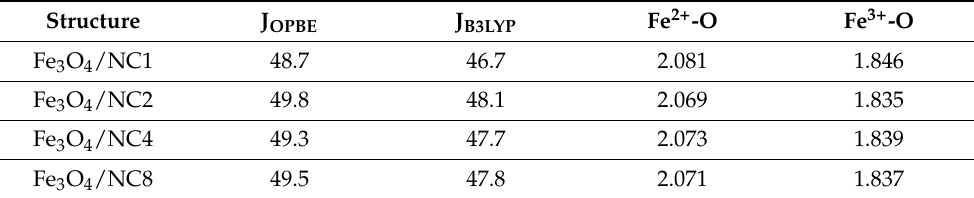
Table 1. Calculated exchange coupling constants (cm − 1 ) at OPBE and B3LYP level of theory and relevant bond distances (Å) from X-ray data.